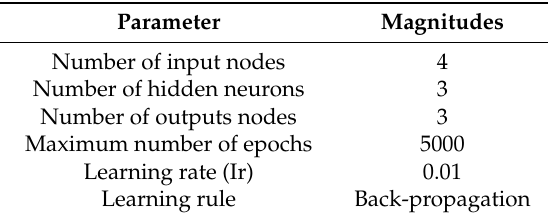
Table 3. ANN training